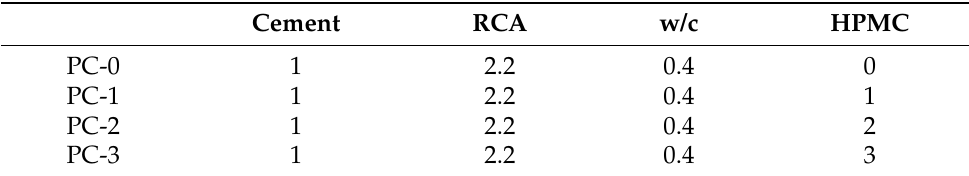
Table 1. Mixing proportions of the porous